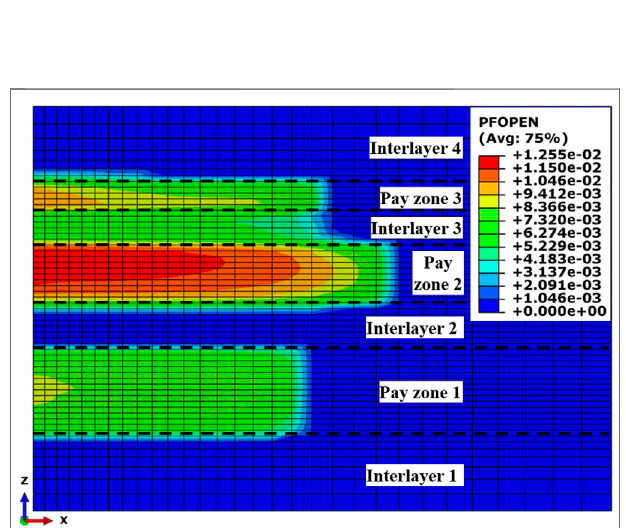
FIGURE 9 | Flow rates of the fl uid into different tunnels and pay zones during injection. (A) Fluid into the six tunnels; (B) Fluid into the three pay zones.